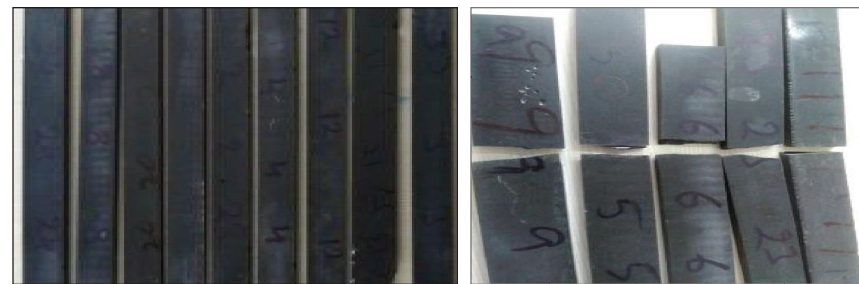
Figure 5: Impact test specimens before and after test.